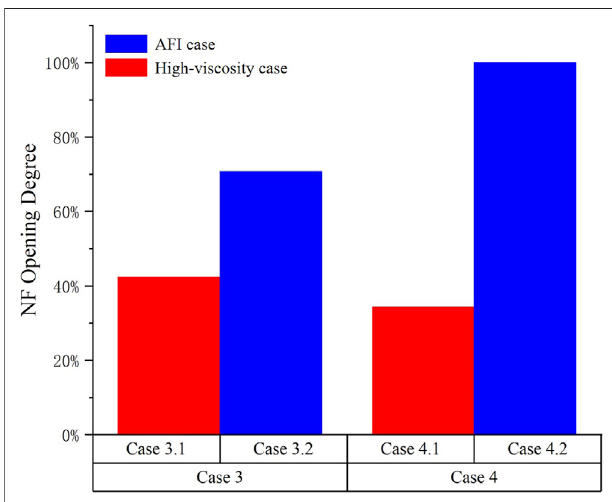
FIGURE 14 | NF opening degree of the AFI and high-viscosity cases.